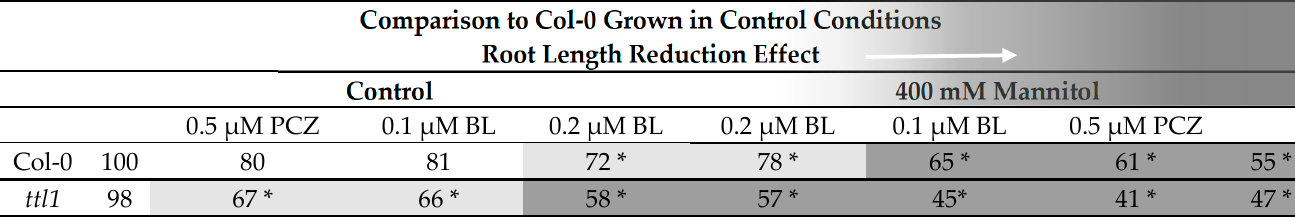
Values are expressed in percentages respect to Col-0 grown in control medium. * indicates statistically significant differences with Col-0 grown in control medium; Student’s t -test p < 0.05, n = 7 and cells with different colors indicates treatments with significantly different effect, the intensity of gray indicates the degree of root length